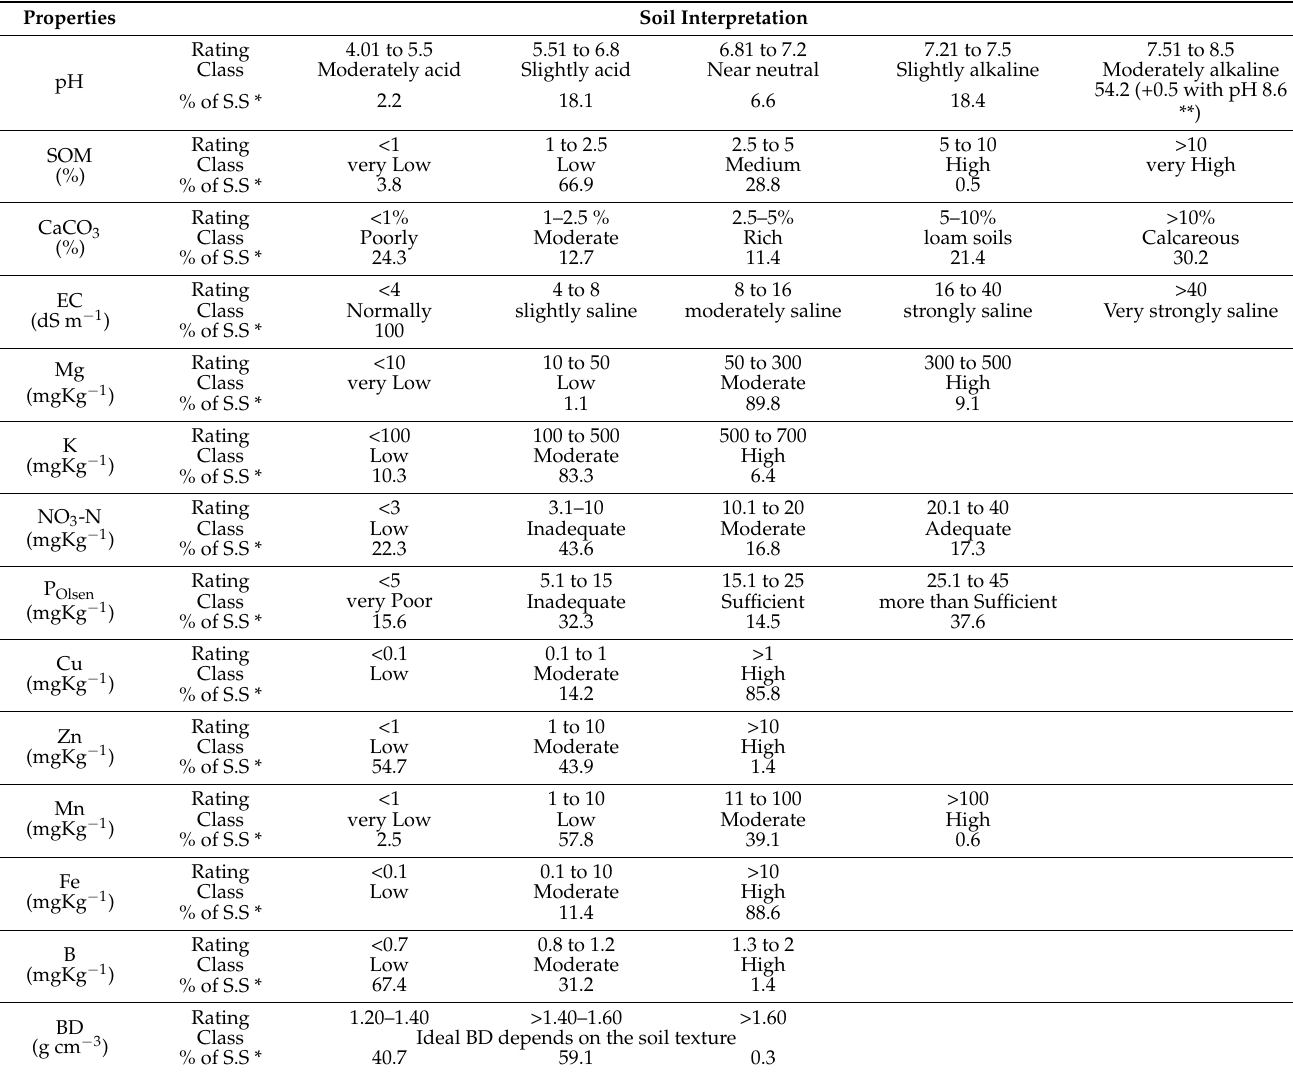
Table 1. Interpretation of soil properties in total study area ( Stotal